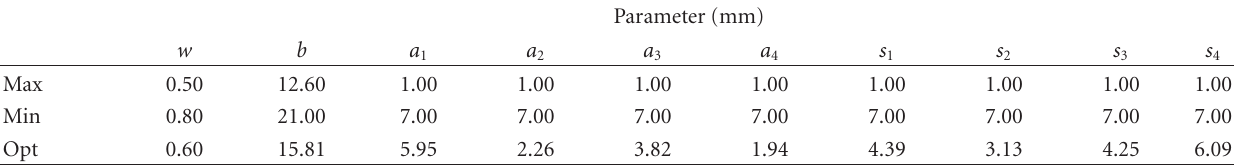
Table 3: Optimization problem variables for formulation worst